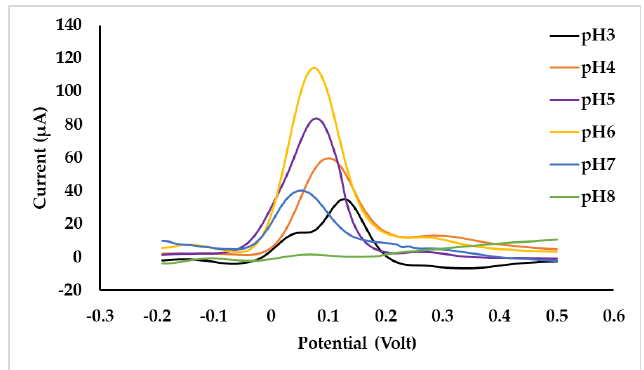
Figure 7. SWV voltammogram of p -AP 50 µM solution at various pHs on SPCE-M-4G.